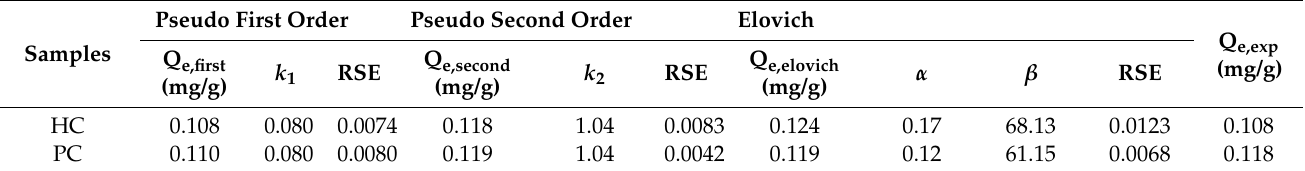
Table 4. Parameters for the Pseudo first order, Pseudo second order and Elovich models for Cd adsorption on PC and